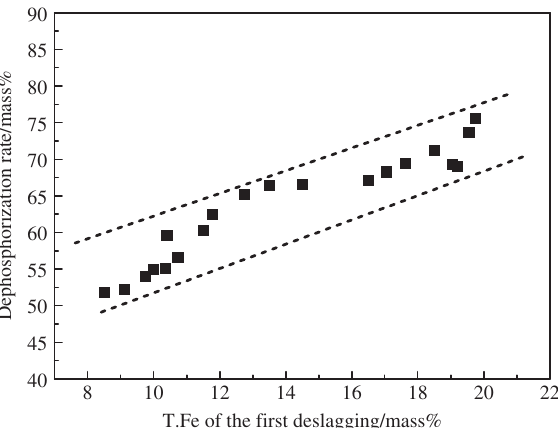
Figure 7: XRD analysis results of mineral phase of the 1# heat and 2# heat at the first deslagging.